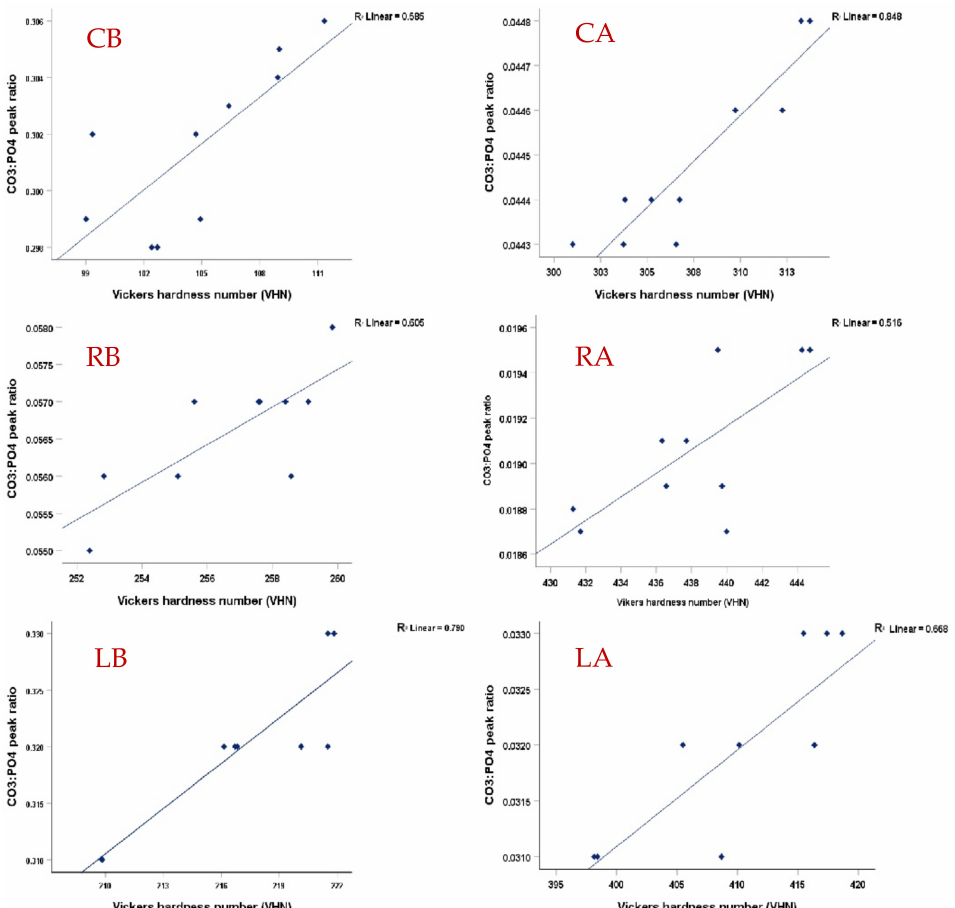
Figure 7. A scatter plot and a regression line (R) demonstrating the presence of a logarithmic regression relationship ( p < 0.05) between the carbonate to phosphate (1070 cm − 1 /960 cm − 1 ) peak ratios and corresponding with Vickers microhardness number (VHN) in each group before and after pH-cycling. The higher peak ratios after pH-cycling in all groups are associated with reduced VHN. The CO 2 -treated surfaces that had lower carbonate content exhibited higher VHN values than other groups before and after pH-cycling (LB,